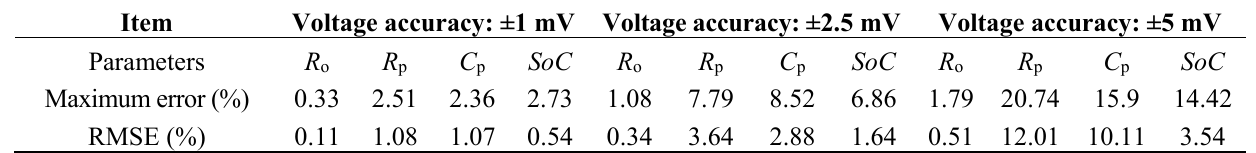
Table 10. The statistical error analysis of model parameters and SoC at the voltage sensor precisions of ±1/±2.5/±5 mV.